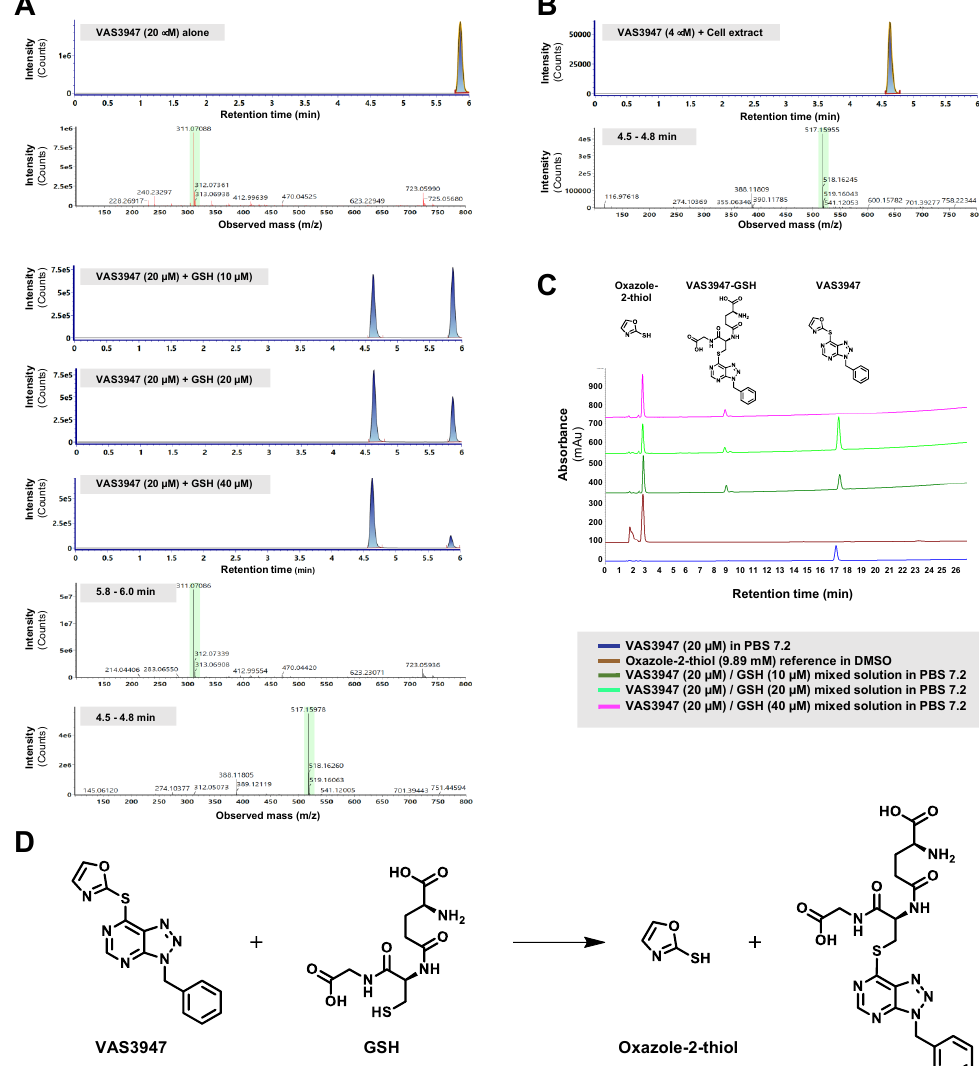
Figure 3. LC-ESI MS and high-performance liquid chromatography (HPLC) analysis of the glutathione (GSH) modification by VAS3947. ( A , B ) Extracted ion current chromatograms and corresponding mass spectra are shown for VAS3947, VAS3947/GSH mixtures at indicated concentrations (20 min incubation), and the cell extracts pretreated with 4 µM VAS3947. ( C ) HPLC analysis for VAS3947, the oxazole-2-thiol, and VAS3947/GSH mixtures at various concentrations. ( D ) MS and HPLC analyses indicate that the thiol function of GSH is alkylated by the benzyltriazolopyrimidine moiety of VAS3947, with the oxazole-2-thiol moiety of VAS3947 serving as a leaving group.